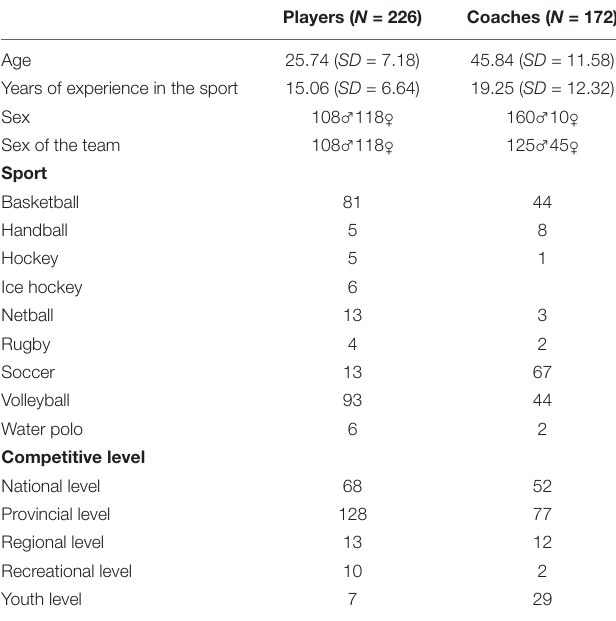
TABLE 2 | Descriptive statistics of the